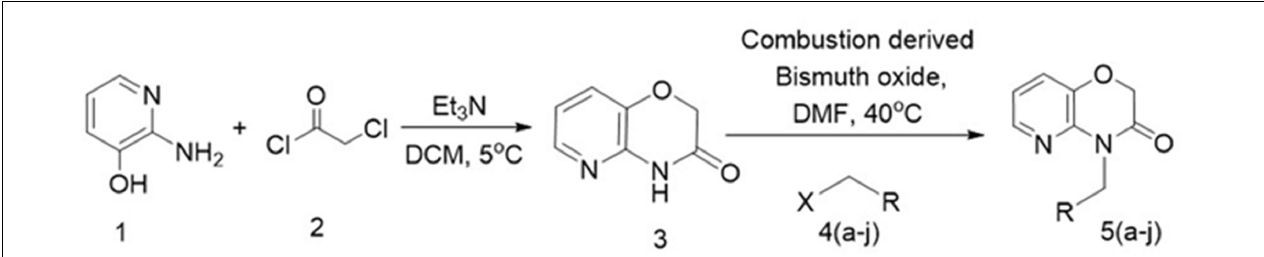
FIGURE 1 | Schematic representation for the synthesis of N-substituted pyrido1,4-oxazin-3-ones.